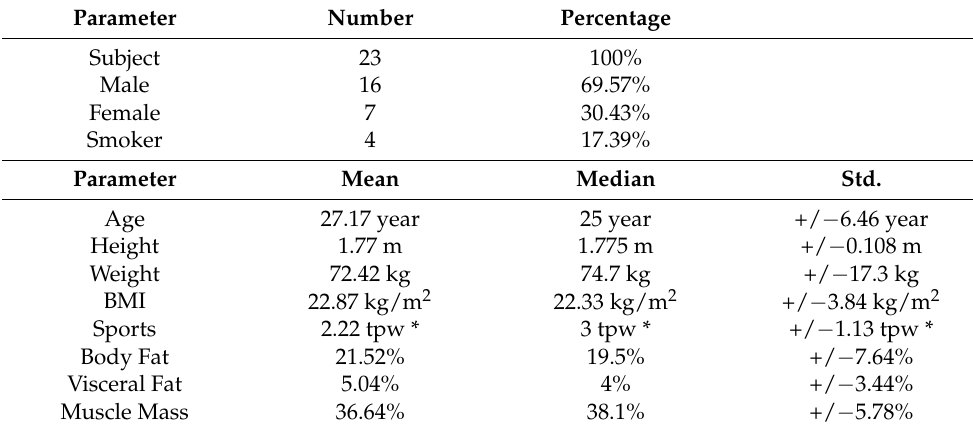
Table 1. Subject